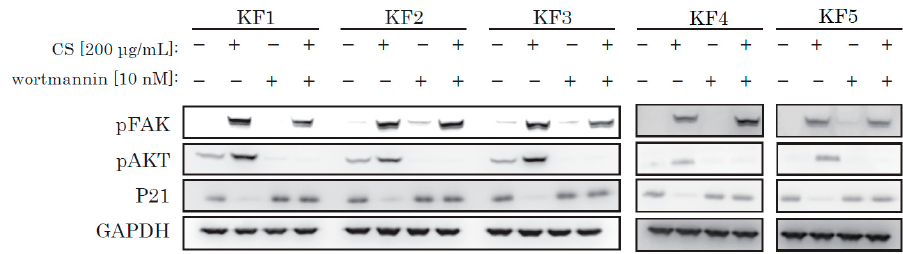
Figure 5. Wortmannin blocked the CS-induced activation of AKT and also blocked a decrease of p21. KFs were incubated with CS and wortmannin and analyzed by Western blotting.